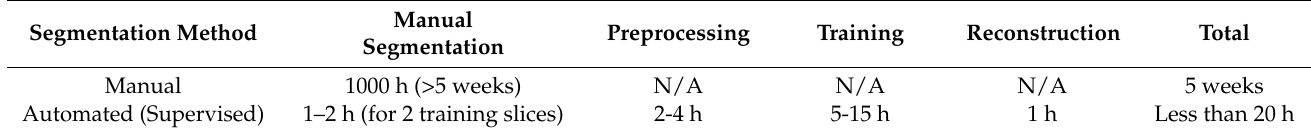
Table 3. Comparison between manual and automated segmentation in terms of duration for 1000 slices.